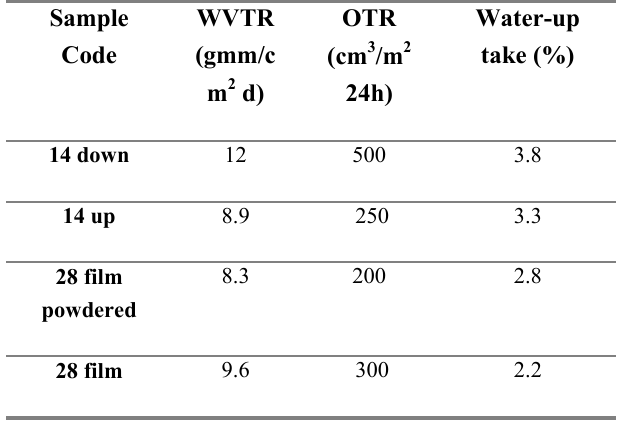
Table 4. Permeability results for analyzed samples.